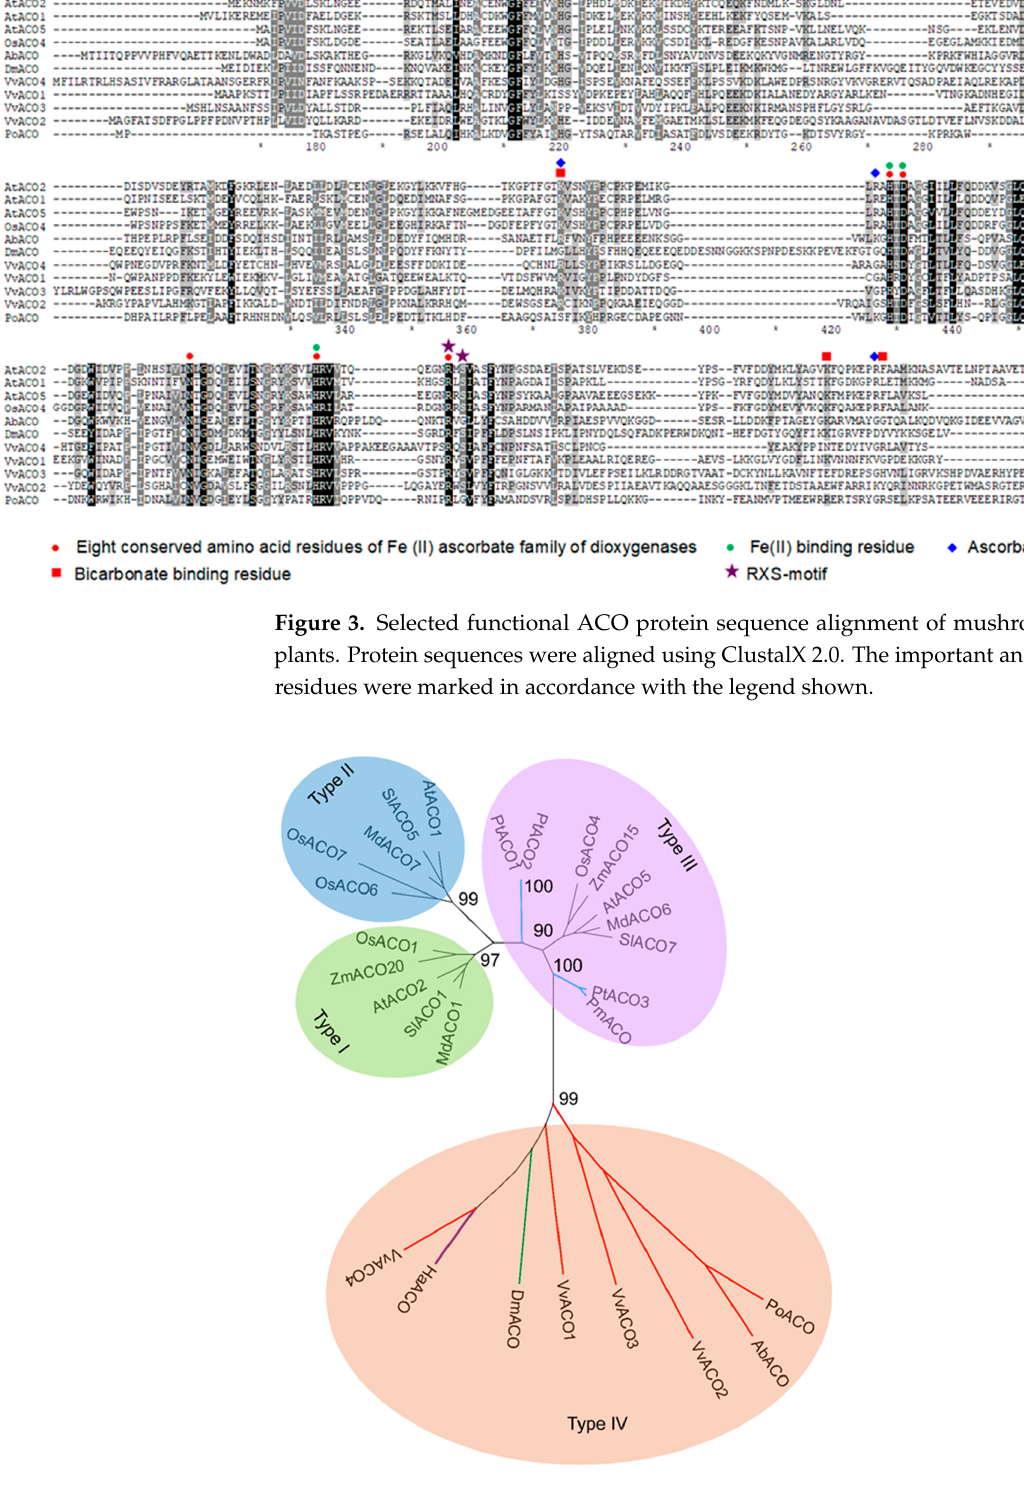
Figure 4. Unrooted phylogenetic tree of 27 ACO proteins generated by MEGA, version 11.0, with the maximum likelihood method. Numbers near branches show percentage bootstrap support. Red clades indicate fungal ACO proteins; blue clades indicate ACO proteins of gymnosperms; green clades indicate the ACO proteins of slime mold; purple clades indicate bacterial ACO proteins; black clades indicate the ACO proteins of angiosperms. The protein sequence information is listed in Ta ‐ ble 2. Five conserved motifs were discovered in the 27 ACOs, which all belong to ACO motifs. The seed plant ACOs all contained these five conserved motifs, except OsACO6 and OsACO7, which had four conserved motifs. The ACOs of bacteria, fungi and slime moulds had only 1–2 conserved motifs, especially VvACO2, and AbACO had only one ACO motif 2 (PIRNAIVVNIGDQJEVJSNGRYKSVWHRV) (Figure 5).